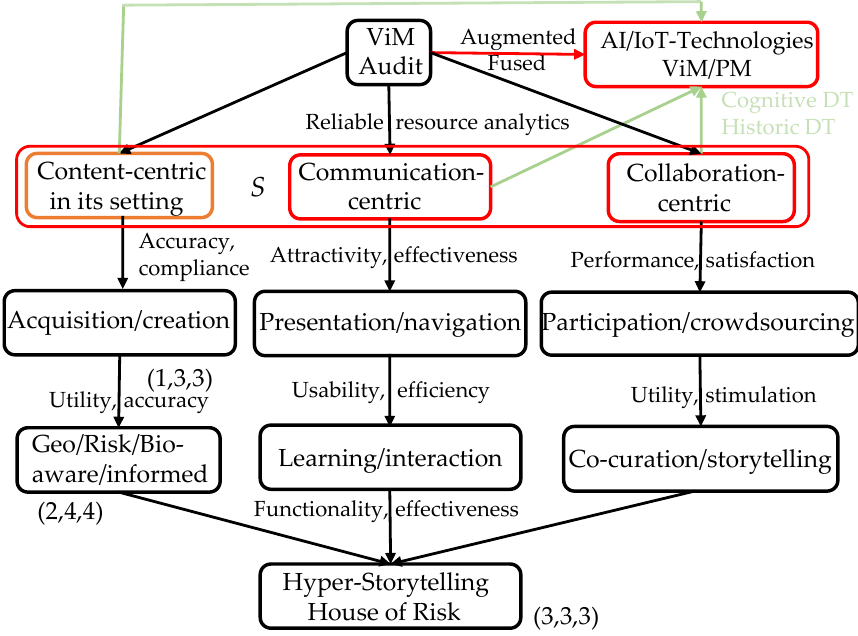
Figure 3. ViMs and their dimensions, DTs and their variants [73].